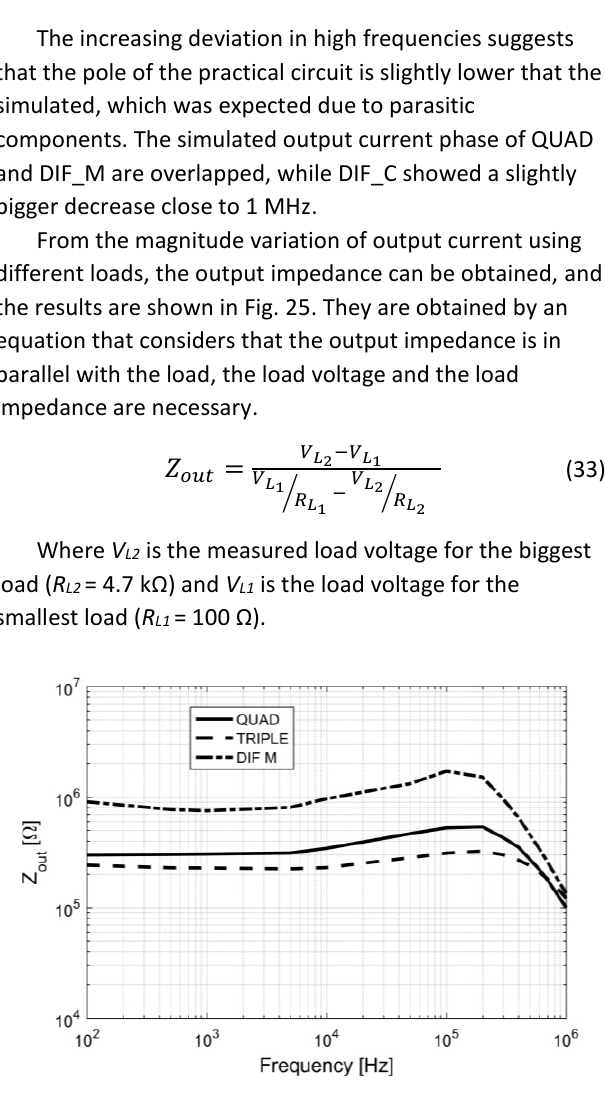
Fig.25: Measured output impedance. a) QUAD b) DIF_C c)